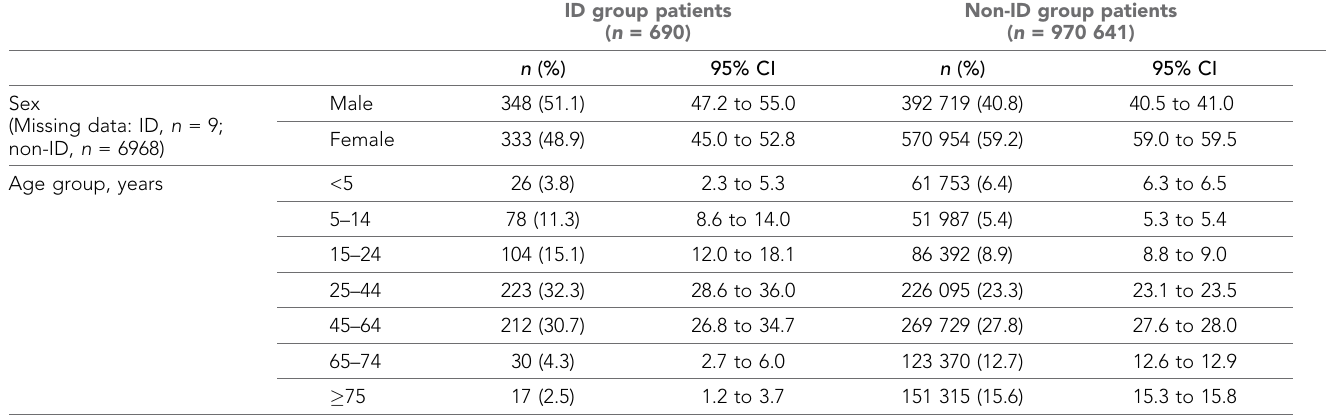
Table 1. Patient sex and age distributions in ID and non-ID group encounters